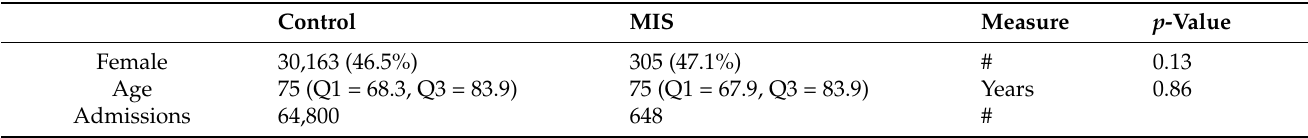
Table 2. Gender and age distribution after PSM.